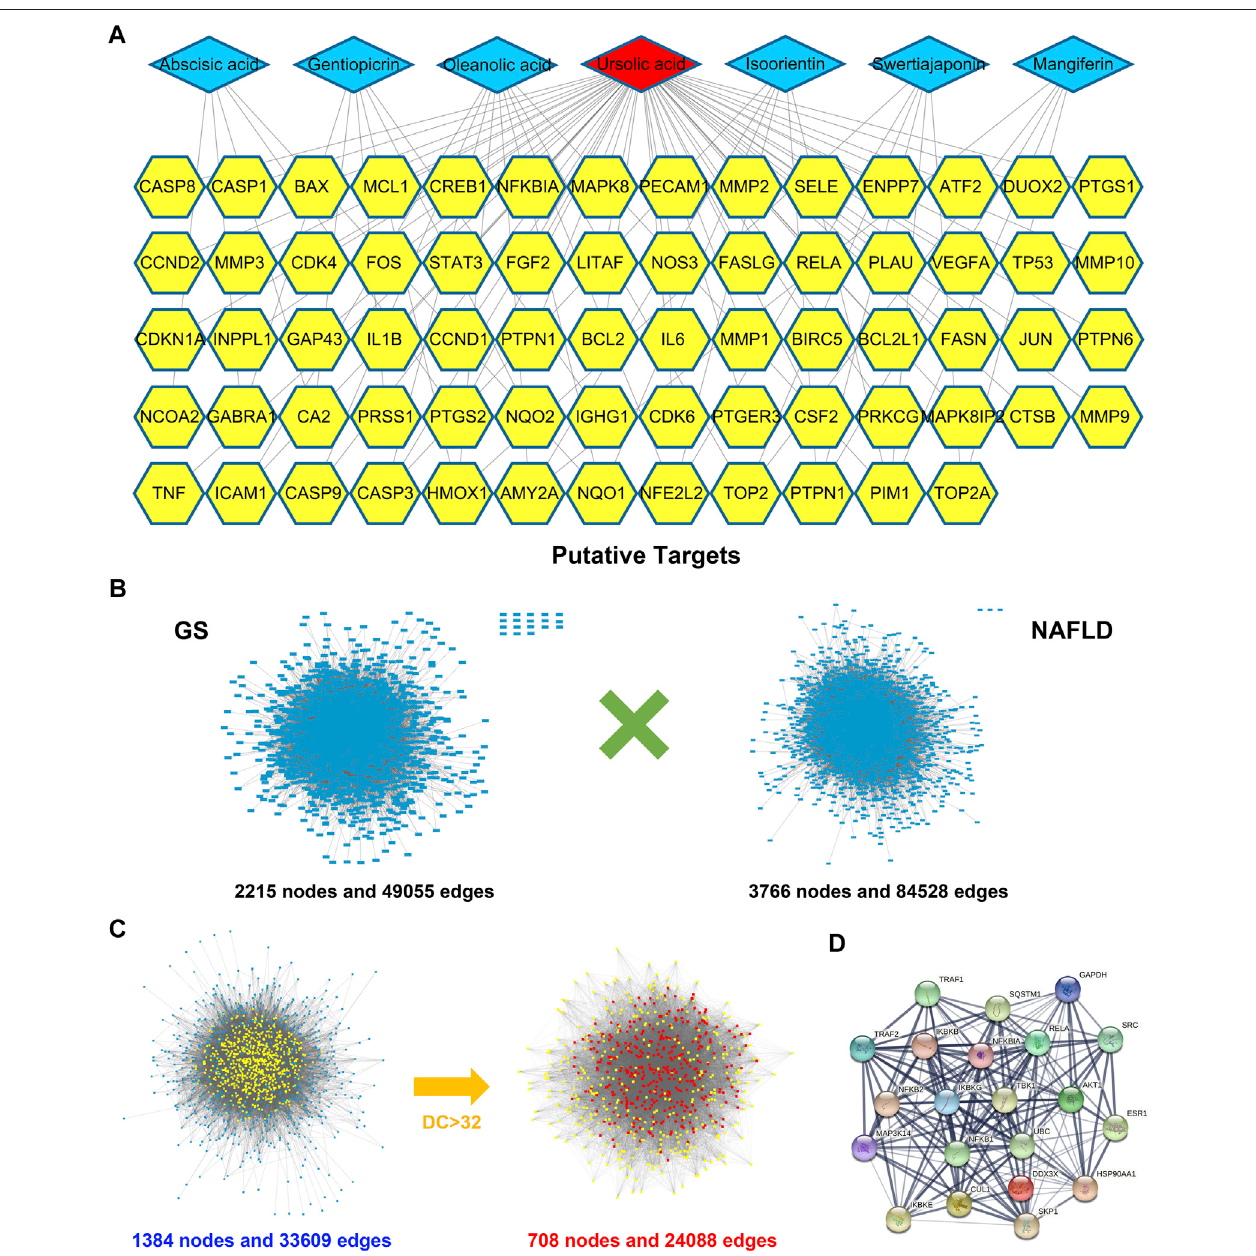
FIGURE 1 | Bioinformatics analysis identi fi ed pharmacodynamic targets of GS. (A) A compound-target network was constructed for the seven candidate compounds of GS and 76 corresponding targets. (B) PPI networks were separately constructed for 76 potential targets of GS and 112 known NAFLD-related targets. (C) PPInetworkswereintersectedtoidentifytheputativetargetsofGSagainstNAFLD,whichwerescreenedbyDCvalue. (D) Anin fl ammation-relatedsignalingnetwork including TBK1 was achieved from the intersected network.